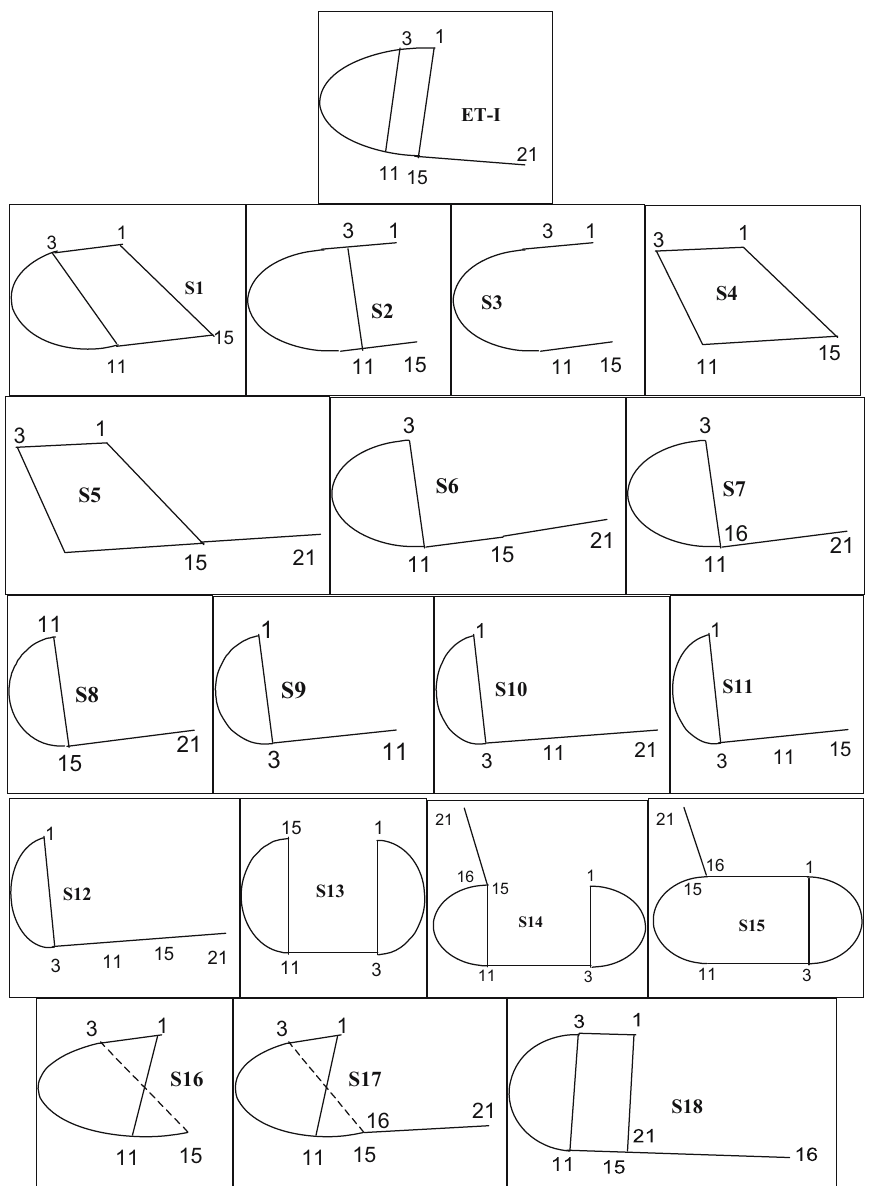
Figure 9: ET - I: structure dissecting approach, all AAs represented by a number are continuous natural chain of ET - I unless stated in the fi gure, all Cys – Cys S – S bonds are straight lines unless otherwise stated; for fi gures S16, and S17, the broken lines represent the S – S bonds between the two Cys residues, Cys 3 – Cys 15